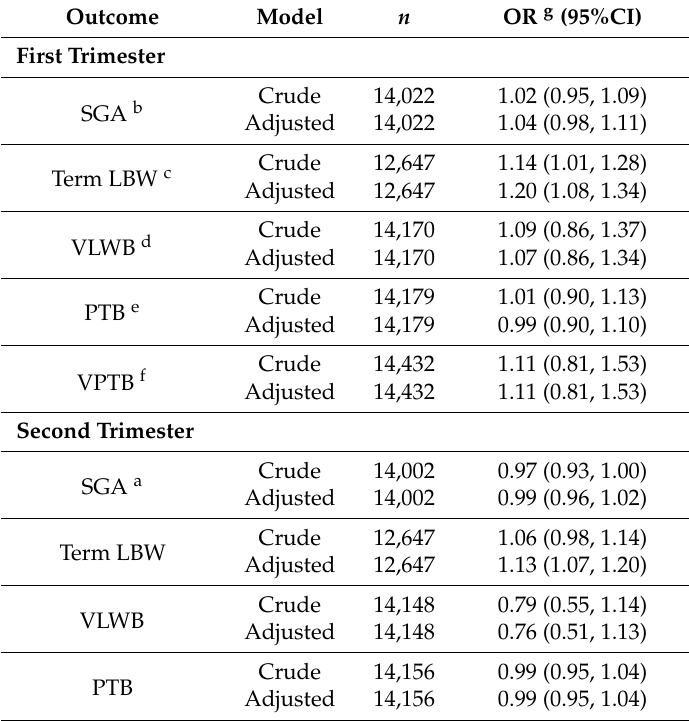
Table 4. Associations a between trimester-specific atrazine concentrations ( µ g/L) and SGA, term LBW, VLBW, PTB and VPTB among AMP communities ( n = 22) in Ohio,